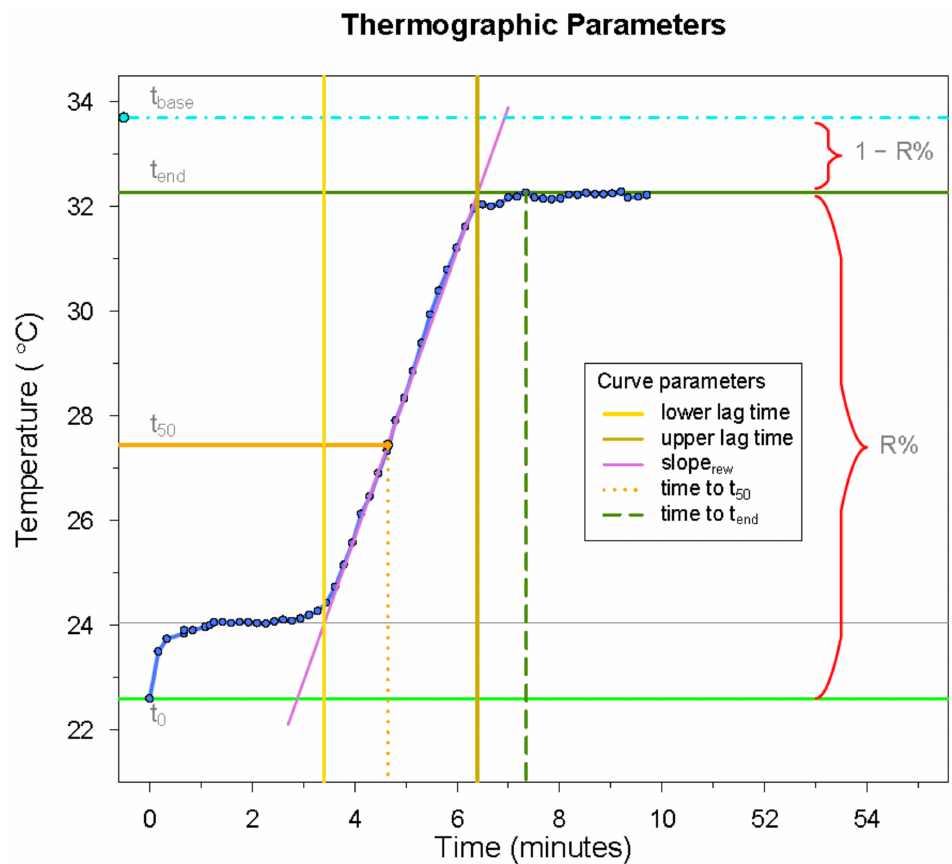
Figure 2. The thermographic parameters initially included in the curve analysis. The S-shaped curve is shown as an example, as the initial analysis on horizontally running curves was unsuc- cessful for some of the parameters. The light blue “dot-dashed” line marks the baseline finger temperature ( t base ), the dark green line marks the end temperature ( t end ), and the percentage tem- perature recovery from the first to the latter is the R% . The vertical “long-dashed” line represents the time to t end . The orange line marks the finger temperature halfway through rewarming ( t 50 ), while the vertical dotted line marks the time to t 50 . The vertical yellow and gold lines represent the lower and upper lag times, respectively. The green horizontal line marks the finger temperature immediately after cooling ( t 0